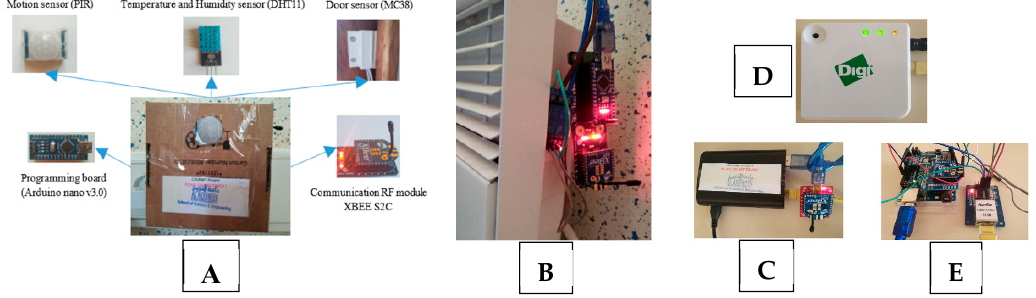
Figure 3. Components of the Wireless Sensor Network (WSN) nodes in the data acquisition ( A ) Arduino nano and its components, ( B ) the installed actuator with the electric heater, ( C – E ) gateway devices.